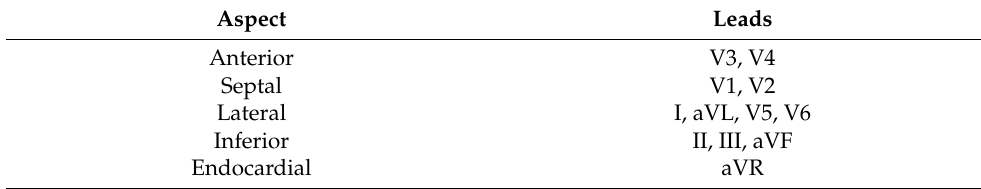
Figure 14. The excitation values learned by the LSE. Table 3. The related anatomical area of each